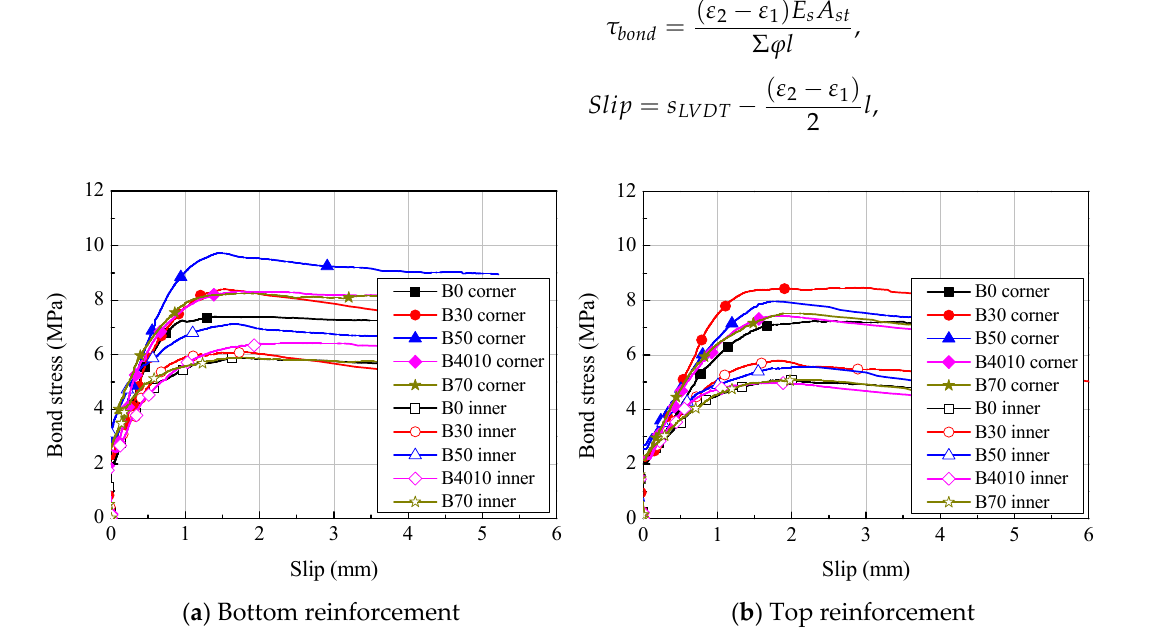
Figure 11. Average bond stress ‐ slip relationships. Table 5. Comparison between analytical and experimental results of B series.